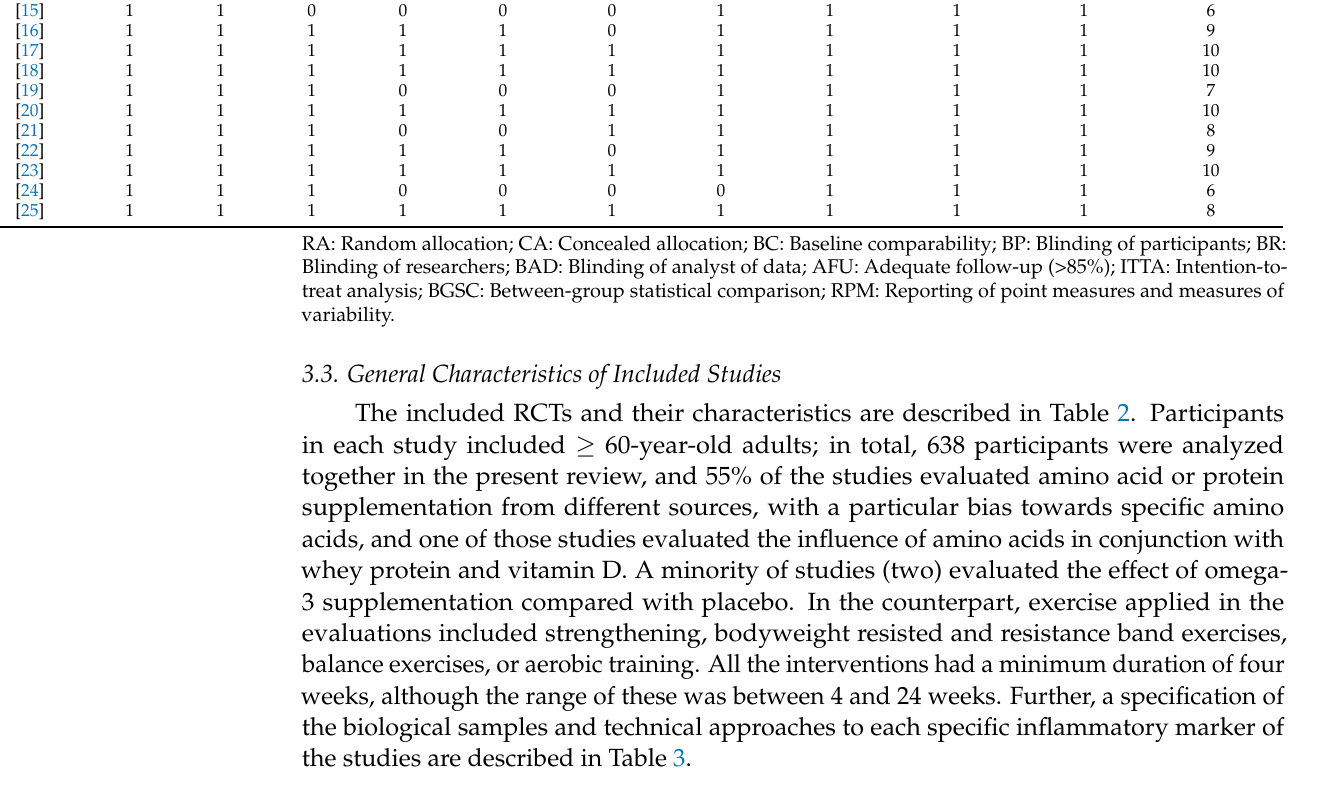
Table 2. Specific characteristics of the studies included in the systematic